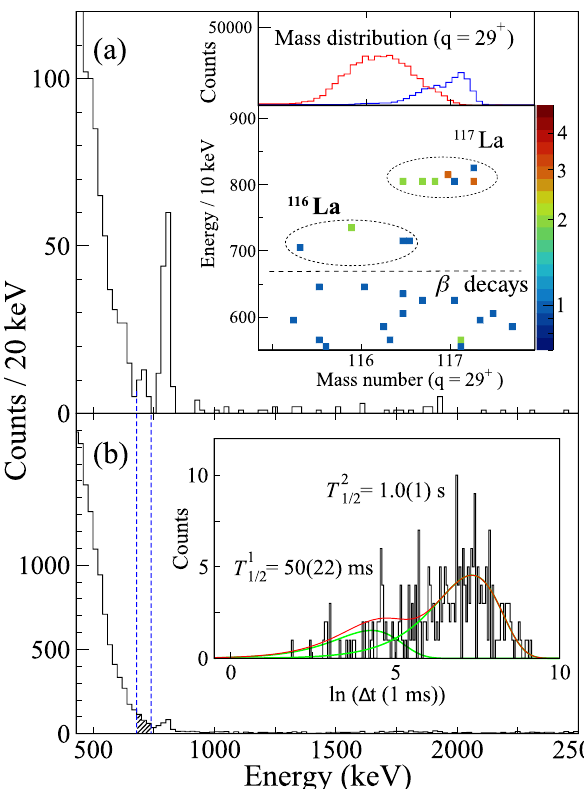
Fig. 5 Experimental data illustrating the observed proton decay of 116 La. The decay events measured in the DSSD were in correlation with a prior detection of a recoil- γ event. a These decay events were required to occur within 100 ms after recoil implantation into the same DSSD quasipixel. The lower inset shows the two-dimensional distribution of ion mass vs decay energy for ions in charge state q = 29 + . The upper inset shows the mass distributions of 116 I and 117 Xe ions from the same experiment measured in MARA drawn in red and blue, respectively. b These decay events were measured within 10 s of a recoil implantation. The blue dashed lines are drawn to illustrate the location of the proton peak of 116 La, as indicated by the shaded area. The inset shows the logarithmic time spectrum of the decay events in the shaded region, fi tted using a two-component function (red). The green curves show each fi tted component. The distribution of higher ln( ▵ t) values corresponds to the random-correlated β -ray background with its effective fi tted